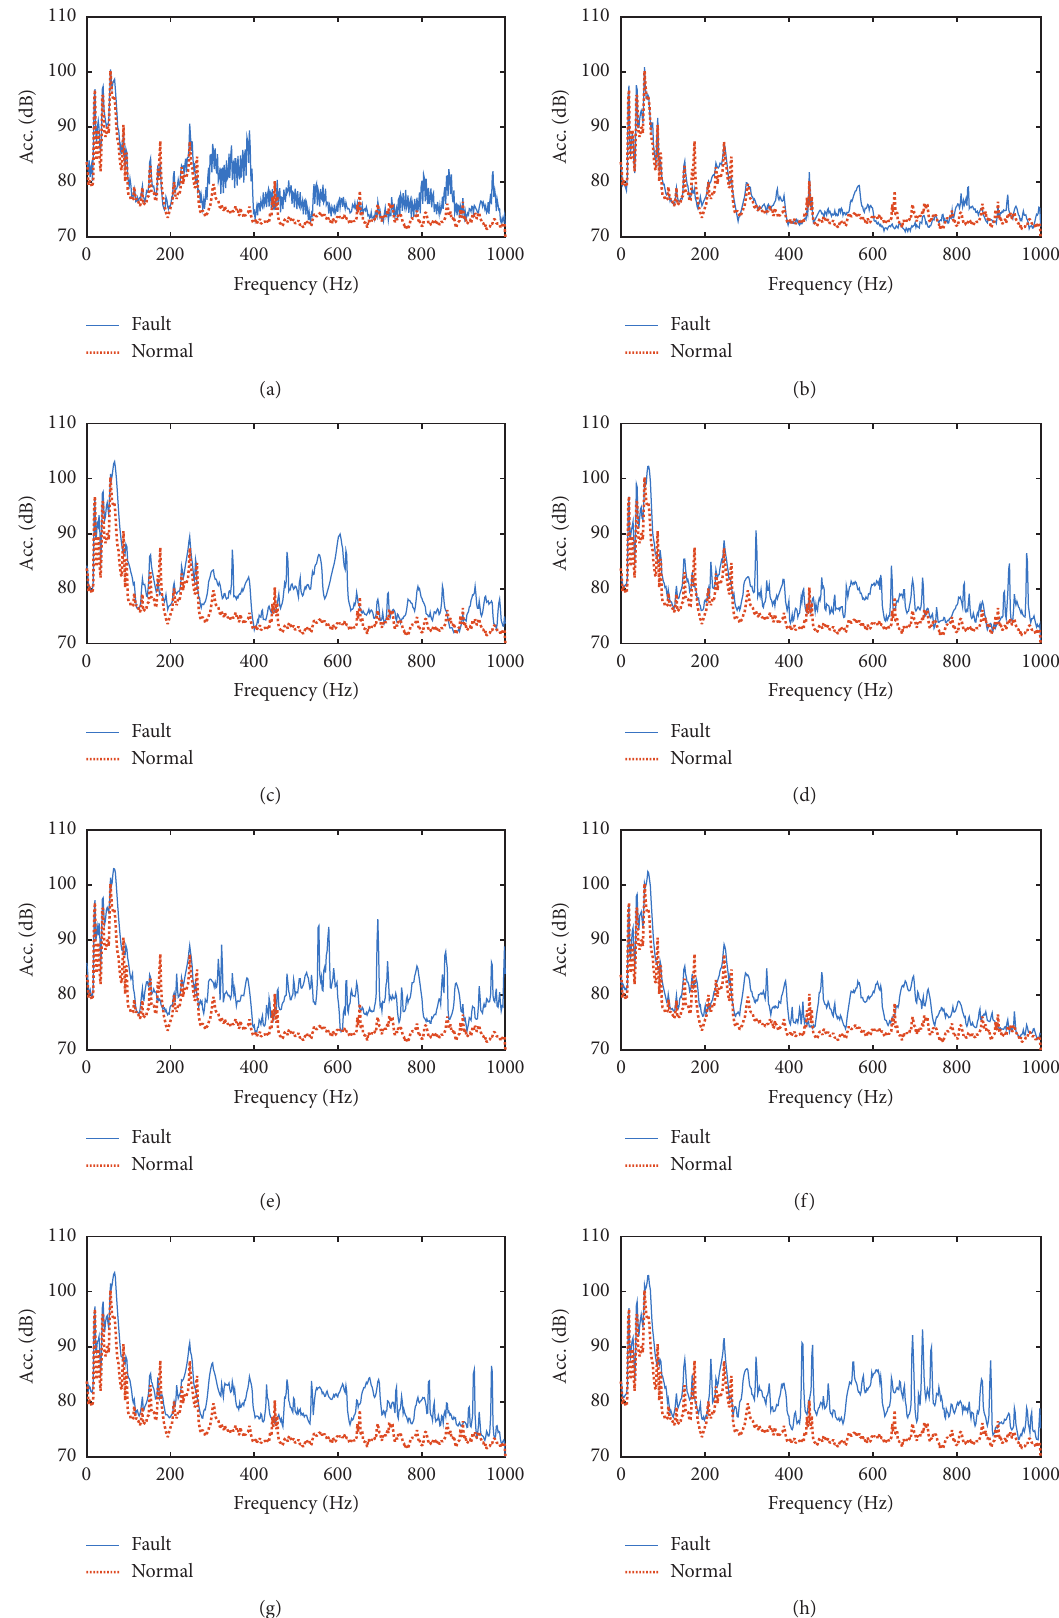
Figure 6: Comparison between spectrum for faults and normal vibration data. (a) Fault no.1. (b) Fault no. 2. (c) Fault no. 3. (d) Fault no. 4. (e) Fault no. 5. (f) Fault no. 6. (g) Fault no. 7. (h) Fault no.